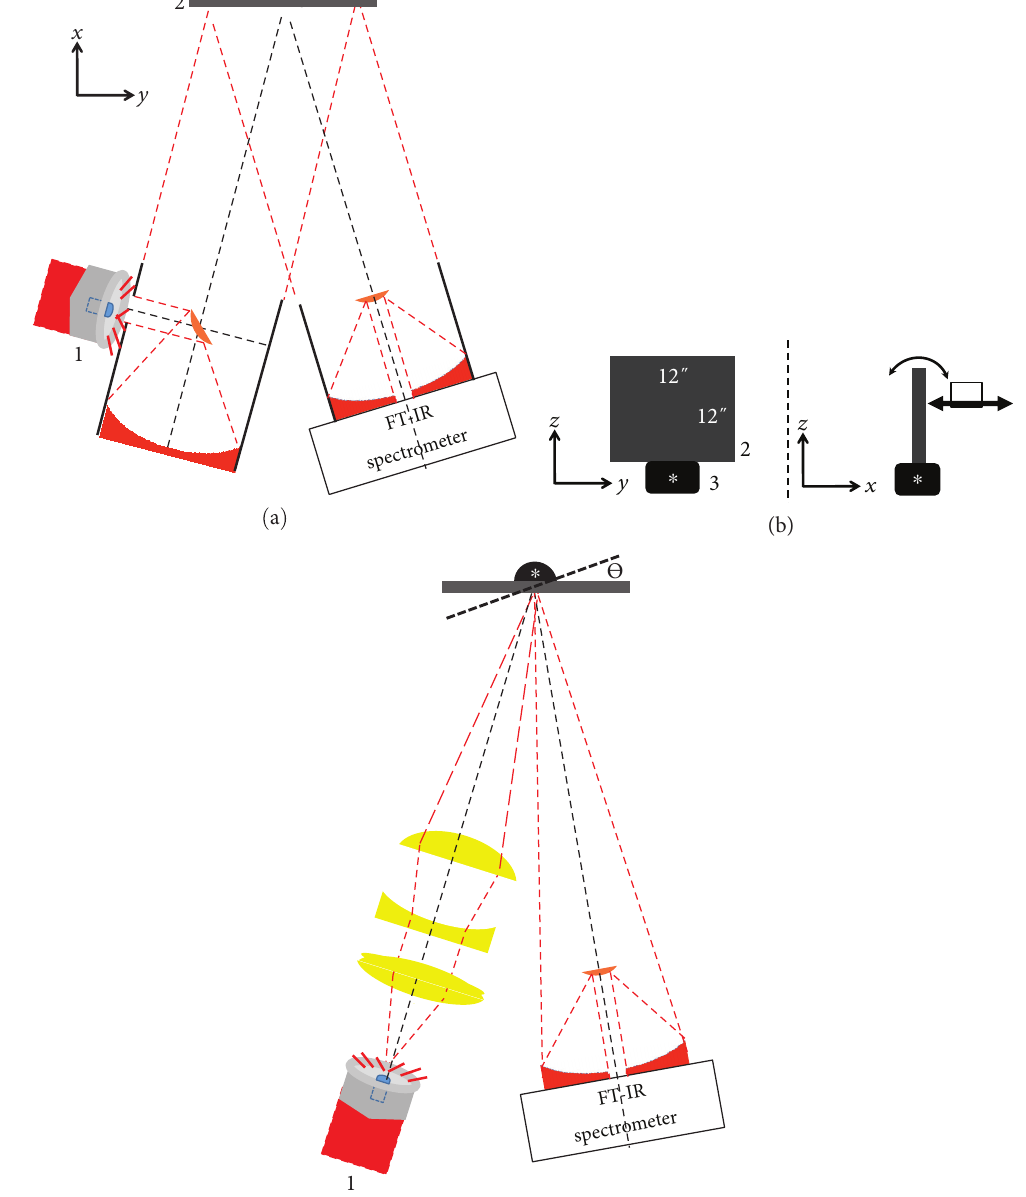
Figure 1: FT-IR interferometer con fi guration: (a) active mode setup for stando ff measurements using re fl ective telescope: 1, IR source, 2, Al plate; (b) plate mount: 3, tilting mount; (c) active mode setup for stando ff measurements using refractive